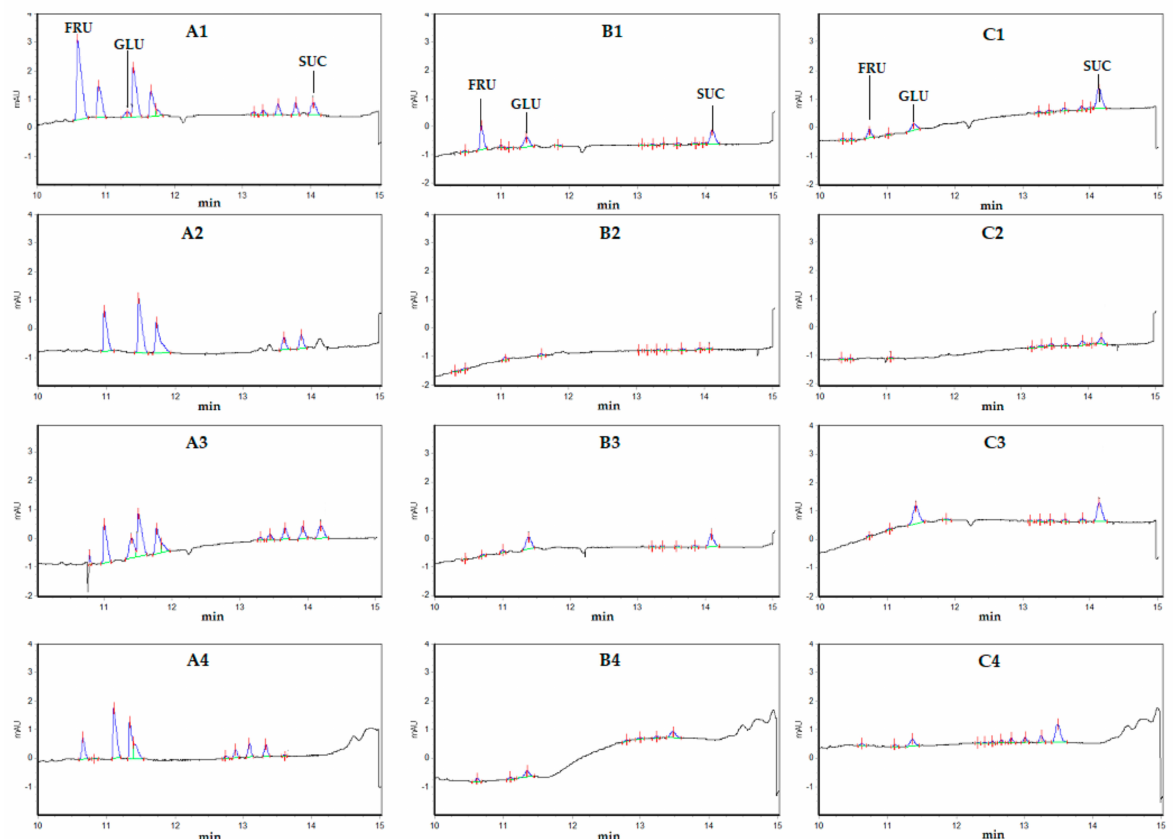
Figure 3. Electropherograms of FOS ( A ), Burd-20 ( B ) or JA-20 ( C ) samples; medium before inoculation ( 1 ) and cultural fluid after 8 h of fermentation of S. aureus monoculture ( 2 ), B. bifidum monoculture ( 3 ), and coculture ( 4 ). Standards were fructose (FRU), glucose (GLU), and sucrose (SUC). The left group of peaks is suggested to correspond to pure fructose oligomers and the right one to glucose-containing